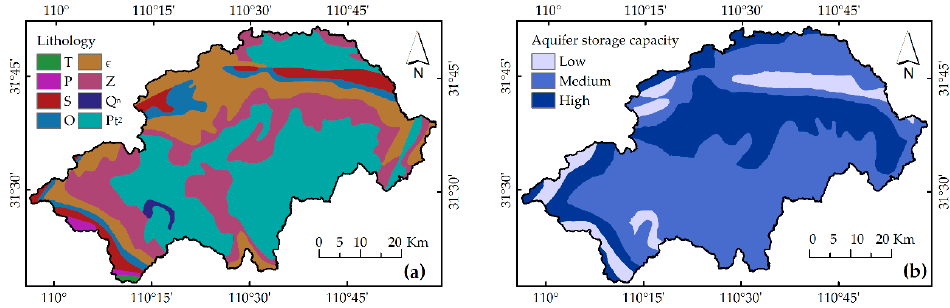
Figure 2. Input layers of influence factors: ( a ) lithology; ( b ) aquifer storage capacity.